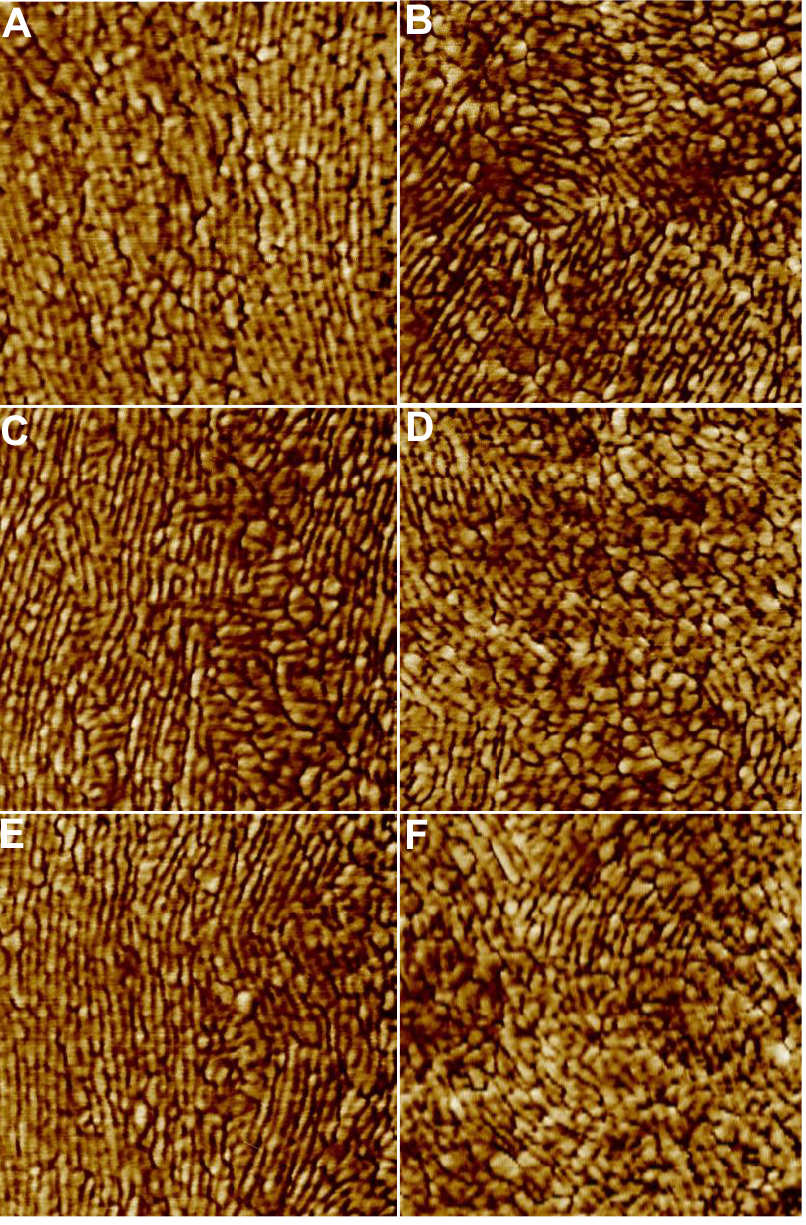
Figure 4. Comparison of phase images of ( A , C , E ) stretched and unstretched ( B , D , F ) Arachnocampa tasmaniensis glowworm threads from the same individual.